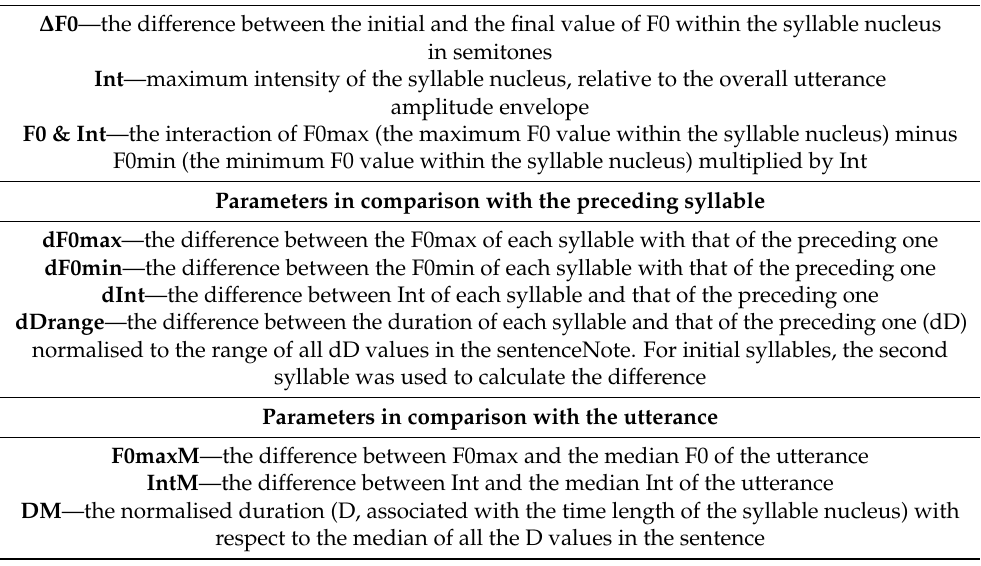
Table 5. Set of parameters derived from F0, Duration, and Intensity used in this study [41]. Parameters inherent to the